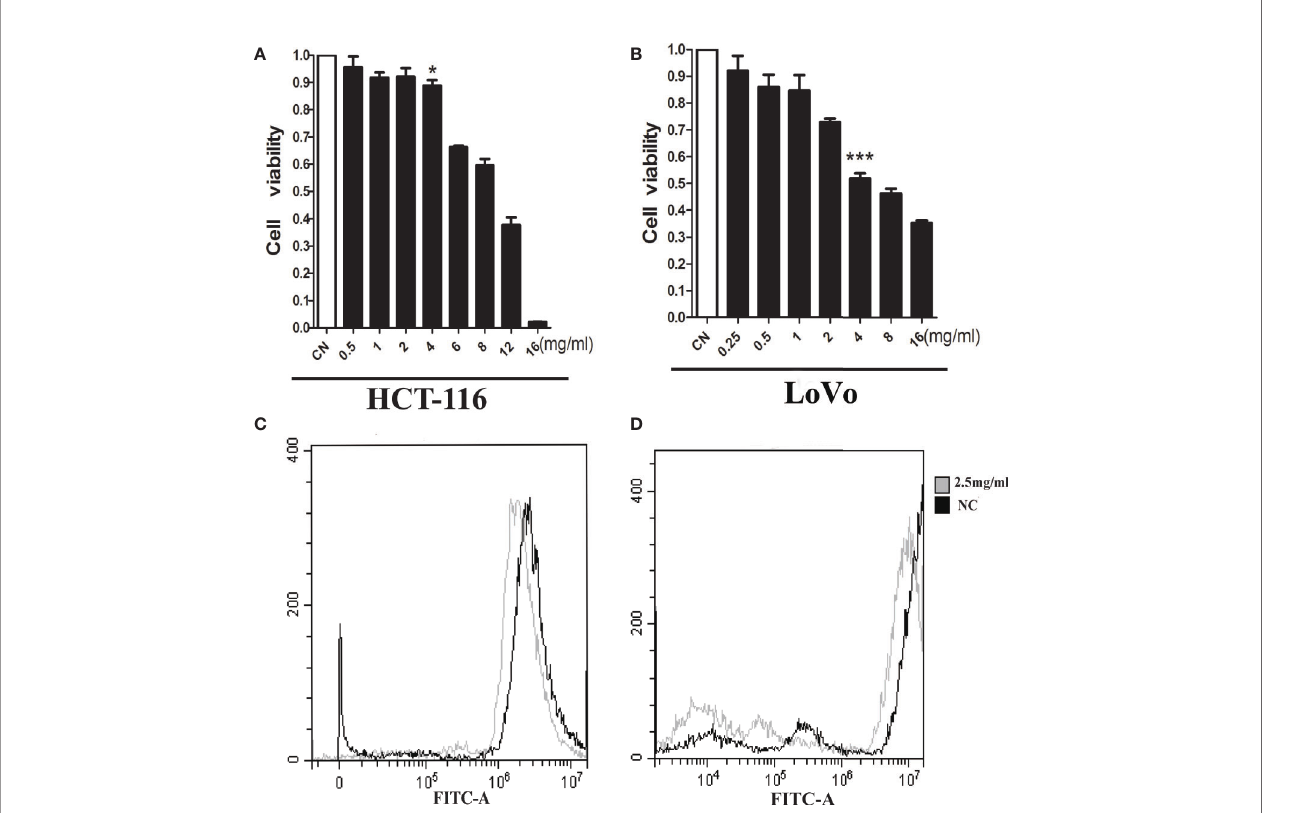
FIGURE 7 | AAM reduces ROS levels and inhibits proliferation in colorectal cancer cells. HCT-116 (A) and LoVo (B) cell proliferation was assayed at 24 h after treatment with AAM at different concentrations; cells were treated with 2.5 mg/ml AAM, and the ROS production of HCT-116 (C) and LoVo (D) cells was evaluated using fl ow cytometry (* P < 0.05, *** P <